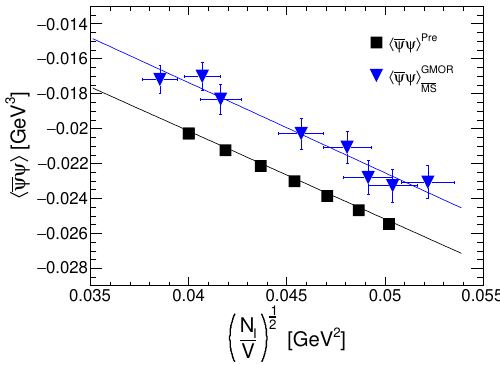
Figure 15 . The chiral condensate a 3 h (cid:22) i versus the square of the pseudoscalar mass ( a (cid:22) m PS ) 2 . The colored symbols and lines rep- resent the numerical results and the (cid:12)tting re- sults, respectively. The dotted line indicates the (cid:12)tting results of the normal con(cid:12)guration.